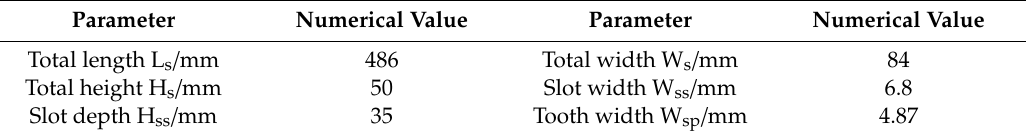
Figure 1. Schematic diagram of the three-phase alternating current (AC) magnetic separator. Table 1. Three-phase alternating current (AC) magnetic separator parameters.